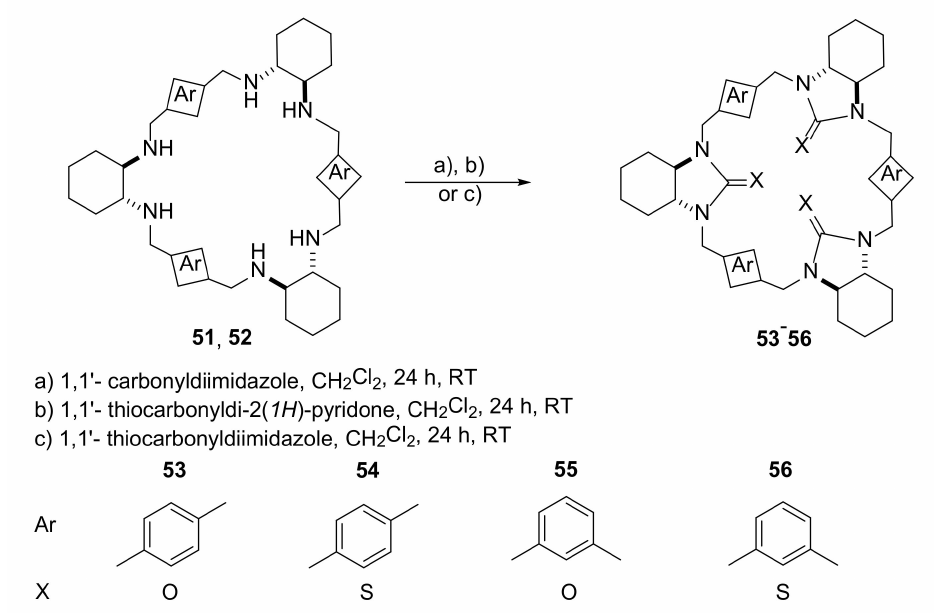
Figure 8. Synthesis of urea and tiourea derivatives of triaglimines 53 – 56 exhibiting gelation